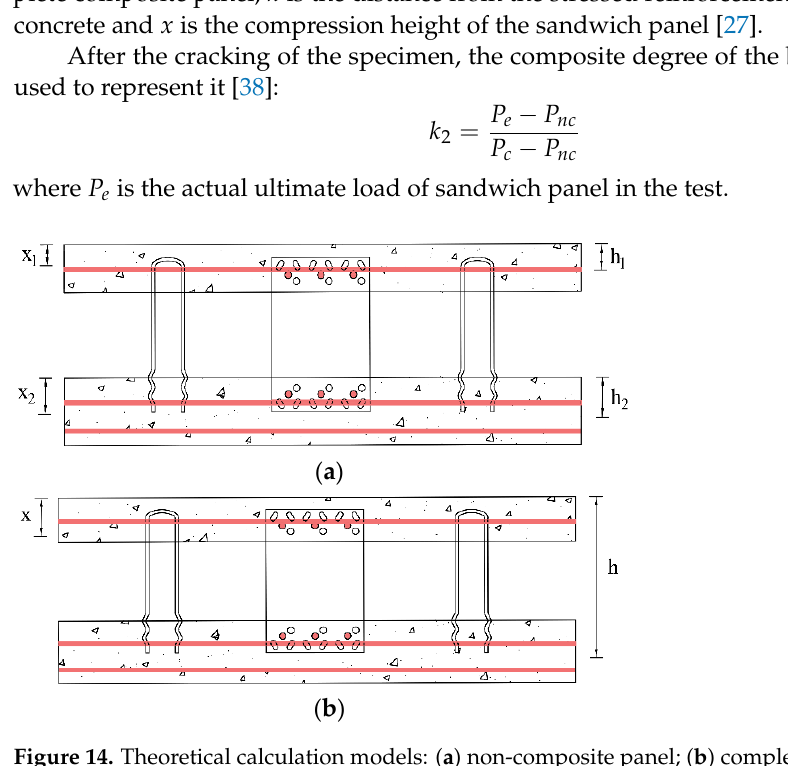
Figure 14. Theoretical calculation models: ( a ) non-composite panel; ( b ) complete composite panel. According to the calculation results and the test data, the rigidity composite degree and bearing-capacity composite degree of each specimen can be obtained, as shown in